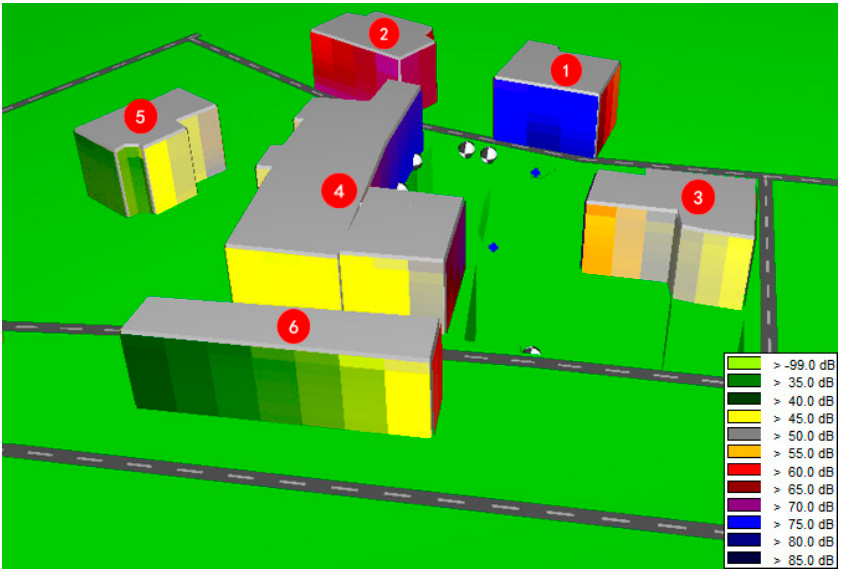
Figure 3. Sound map of the construction site and its vicinity. Table 5 . Simulated noise levels in the surrounding buildings (unit: dB(A)).